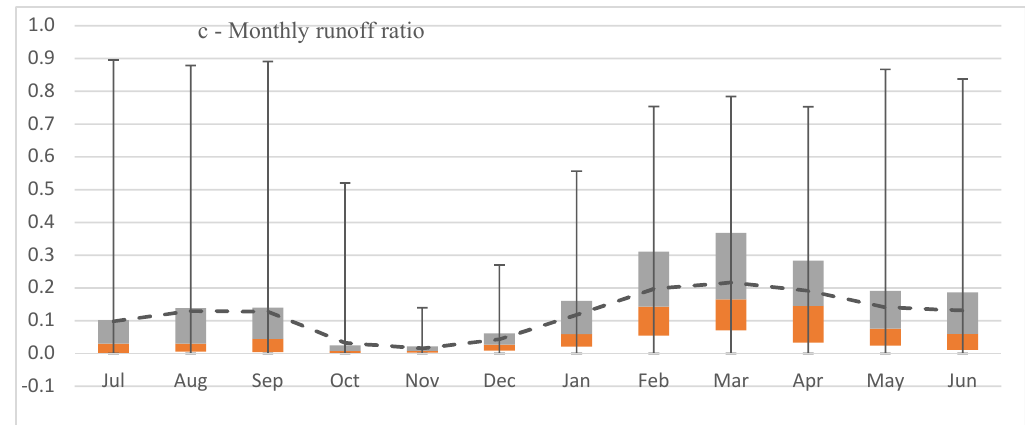
Figure 5. Distribution of monthly rainfall ( a ); runoff ( b ) and runoff ratio ( c ) in Upper Burdekin. Monthly analysis is based on data records at Sellheim gauging station 1948–2016.